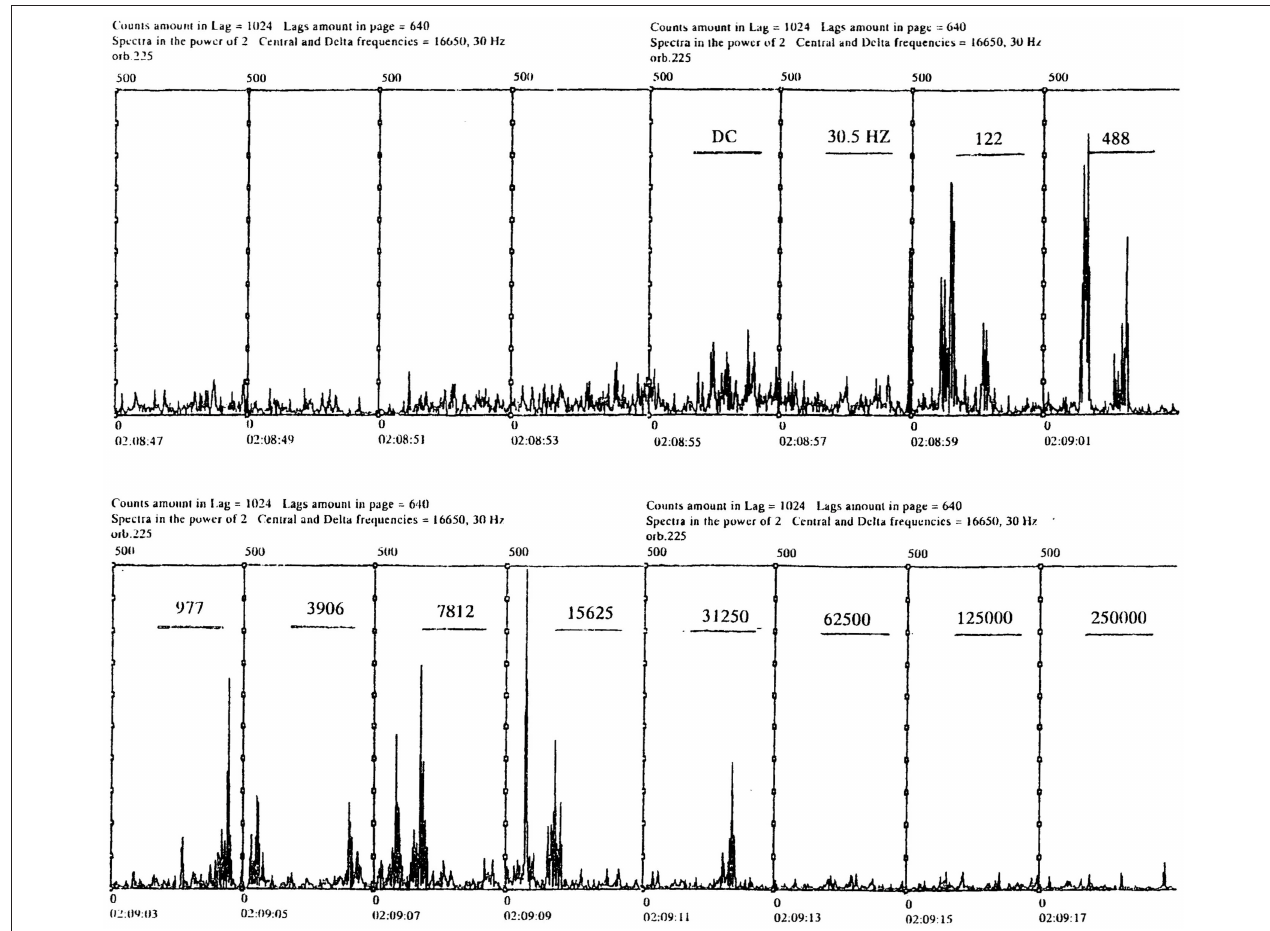
FIGURE 13 | Wave intensity registered by MAGION–3 at the frequency 16,650 Hz , i.e., 150 Hz away from the VLF transmitter carrier. The electron beam pulses are shown as horizontal bars with the modulation frequency indicated. (Reprinted from Oraevsky et al., 1994, with permission from Elsevier).